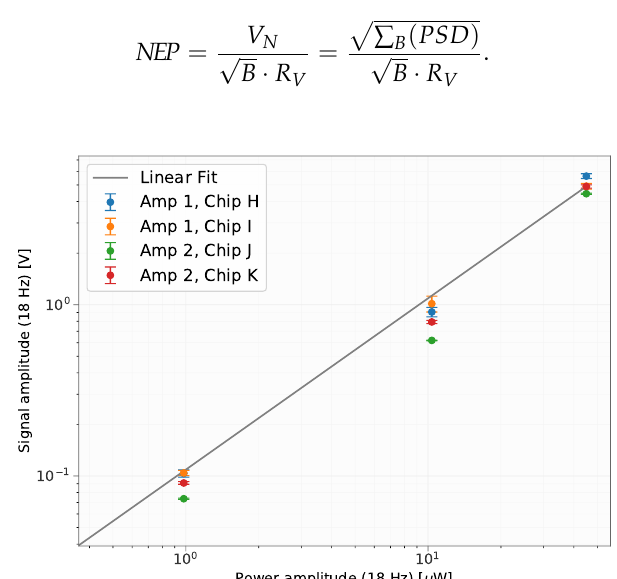
Figure 7. The response of the detector (amplitude at 18Hz, V S ,18Hz ) as a function of the incident power at 18Hz ( P 0,18Hz ) that was irradiated onto the detector. The fit was conducted using the entire data set shown in the plot. It was also repeated for the specific data associated with each individual configuration, which led to virtually the same result for the response R V when taking the mean value of the individual